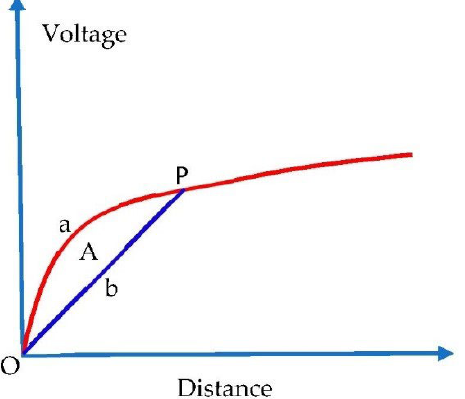
Figure 1. The distance–voltage diagram depicting the procedure to obtain the length of the streamer region. The curve marked ‘a’ gives the potential ahead of the tip of the rod marked ‘O’ caused by the background electric field. The curve marked ‘b’ defines the line with a potential gradient identical to that of the streamer channel. The two curves cross each other at P and the area between the two curves is denoted by ‘A’.